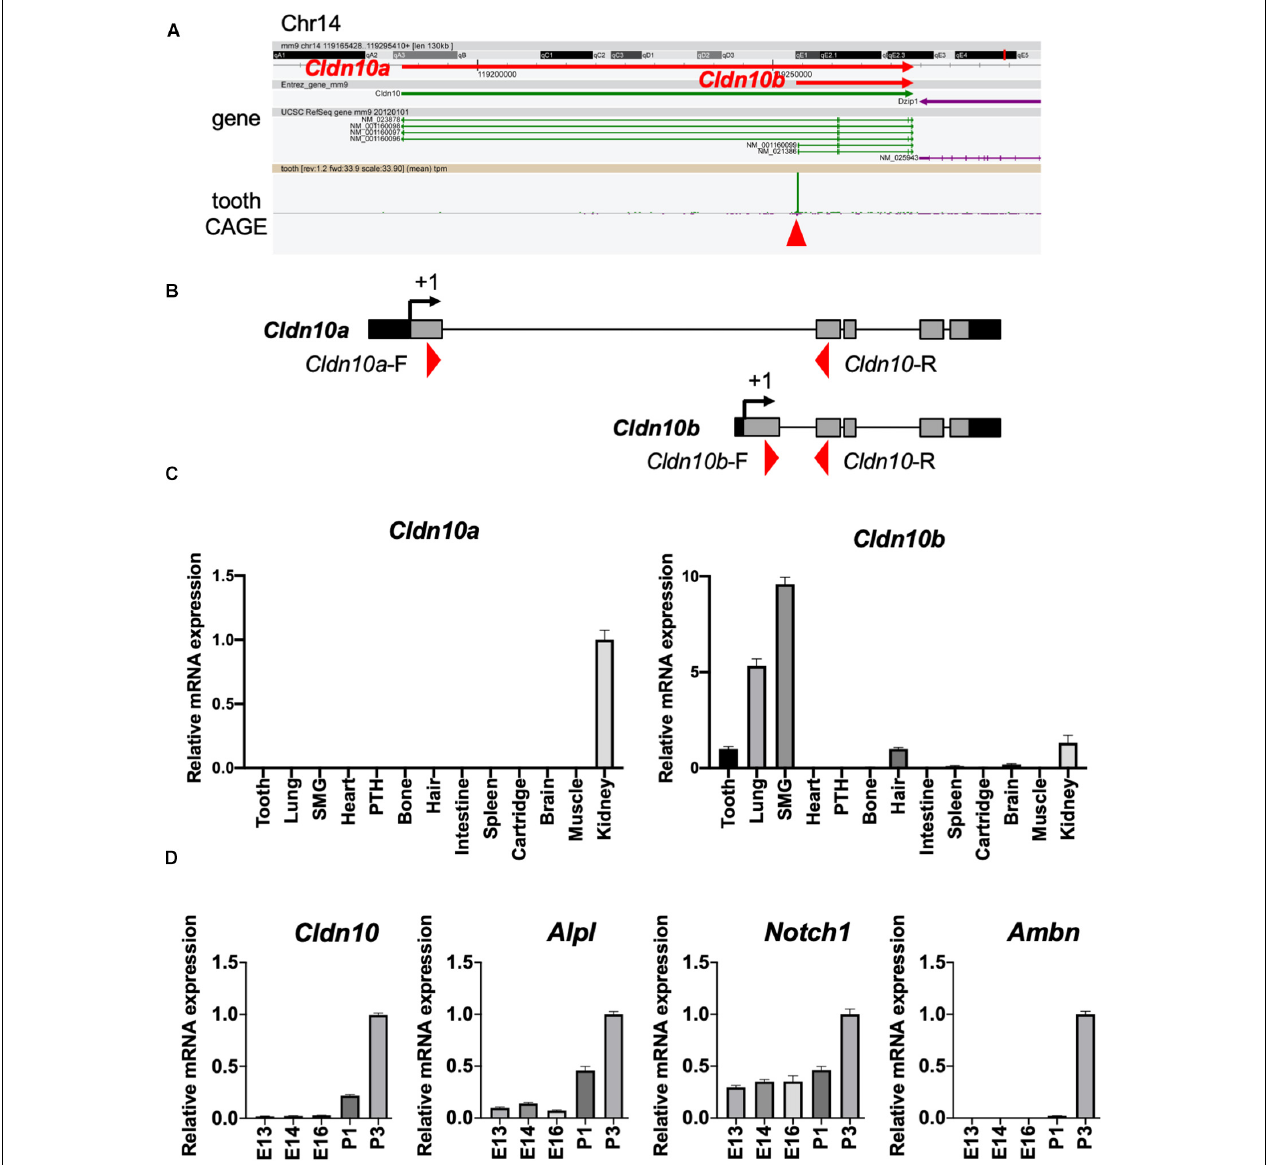
FIGURE 2 | Expression patterns of Cldn10 during tooth development. (A) Genomic locus of mouse Cldn10 in Cap Analysis Gene Expression (CAGE). The CAGE dataset from tooth germs showed a high peak at the Cldn10b transcription start site. The red arrowhead indicates the CAGE peak. (B) Schematic summary of Cldn10 isoforms in the rat genomic locus. Red arrowheads indicate the locations of intron-spanning primers used in quantitative reverse transcription polymerase chain reaction (RT-qPCR). (C) Expression levels of Cldn10 mRNA isoforms a and b in postnatal (P) day P7 rat tissues ( n = 3). The relative mRNA expression was standardized to Gapdh expression. Error bars represent S.D. SMG , submandibular gland; PTH , parathyroid. (D) mRNA expression levels of Cldn10 , SI cell markers Alpl and Notch1 , and ameloblast marker Ambn at different developmental stages of mouse tooth germ ( n = 3). The relative mRNA expression was standardized to Gapdh expression. Error bars represent